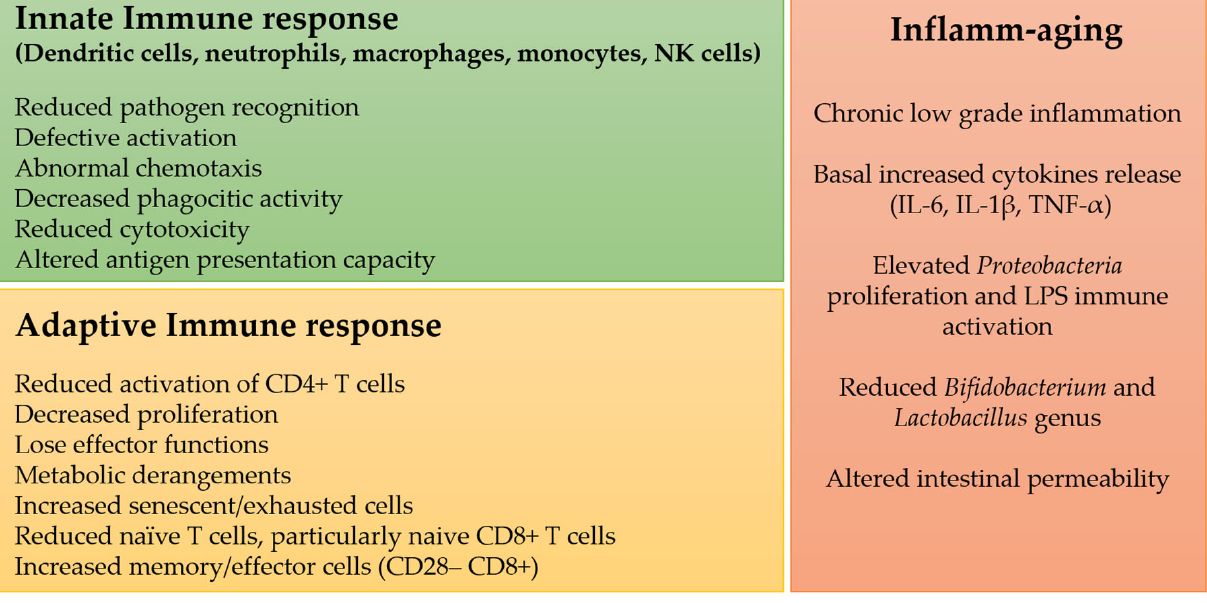
Figure 1. Changes in the innate and adaptive immune response and chronic inflammation during immunosenescence and aging.